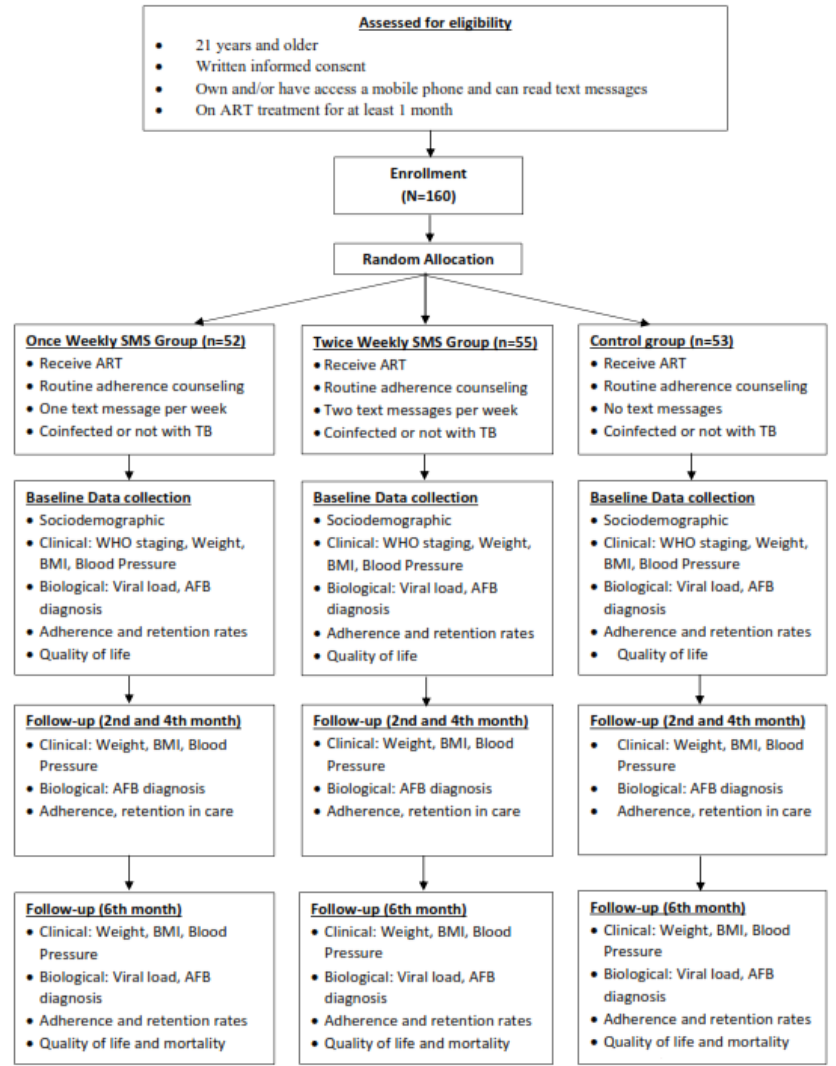
Figure 1. Recruitment and random allocation into the text messaging and control groups. AFB: acid-fast bacilli; ART: antiretroviral therapy; TB: tuberculosis; WHO: World Health